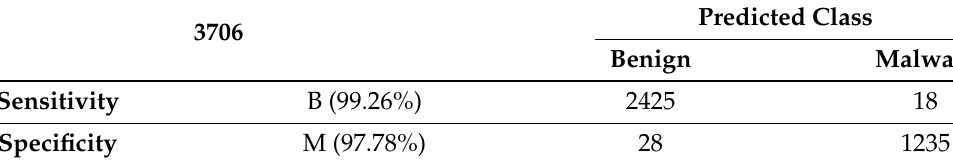
Table 6. SVM Confusion matrix.